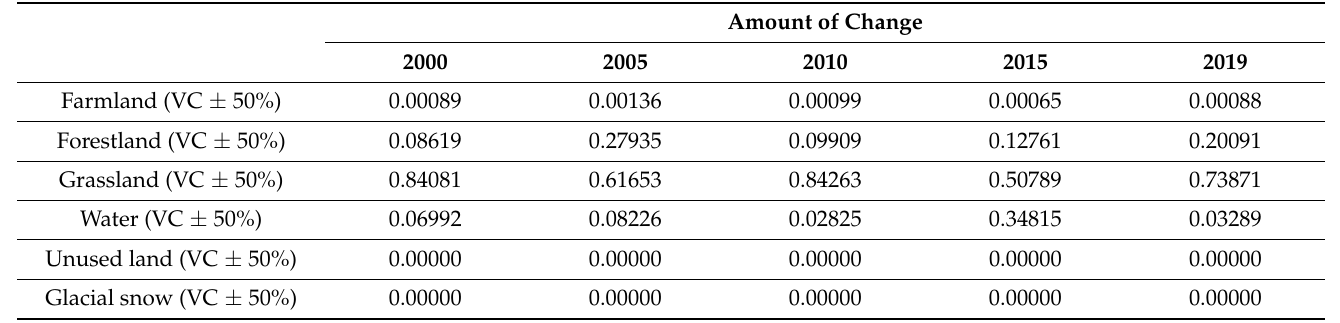
Table 9. Ecosystem service value sensitivity index by land type in Qilian Mountain National Park (Gansu